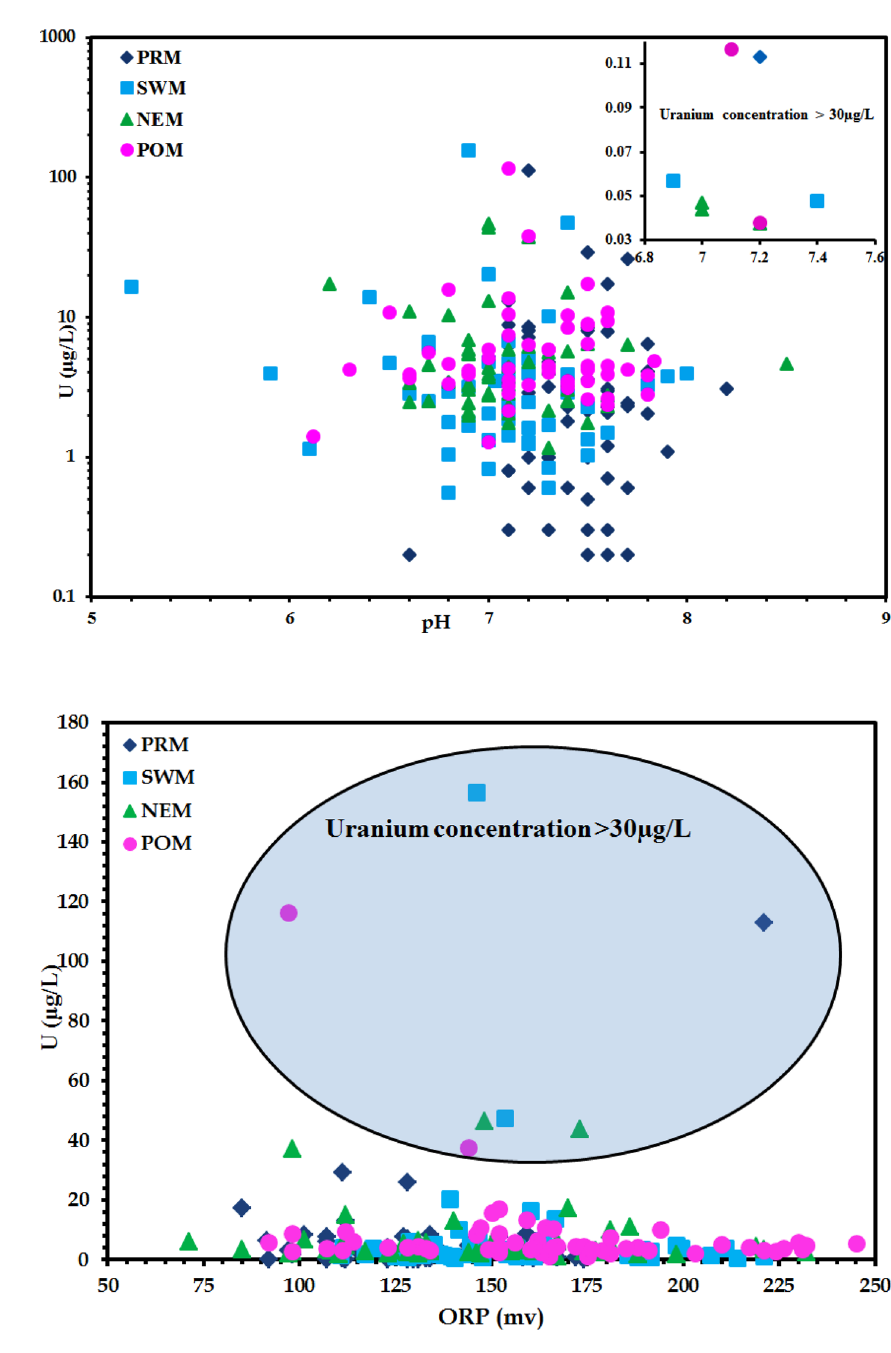
Fig. 6 Interrelationship between pH and U in groundwater sam- ples collected during all four seasons